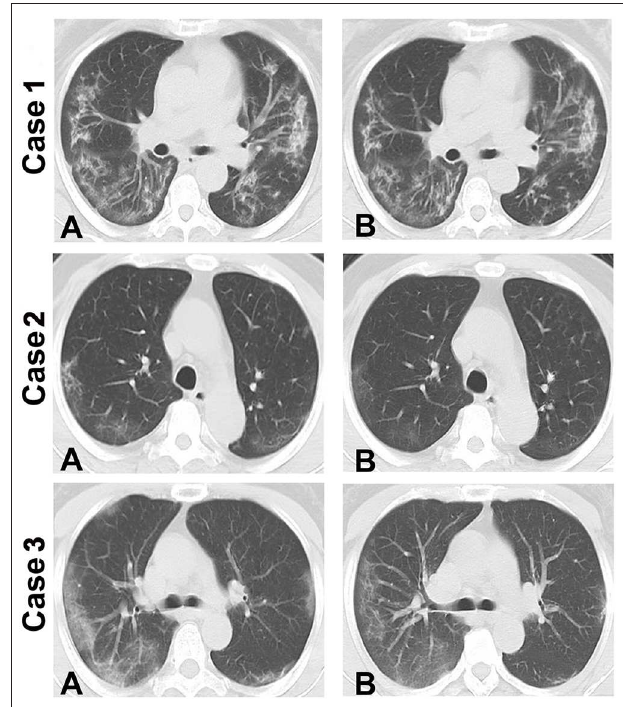
FIGURE 1 | Chest CT showing changes in 3 patients with severe COVID-19. Compared to the first transferred to ICU, chest CT showing significant absorption of exudative lesions in patient of the day before they were discharged from the ICU. (A) Chest CT images of the patients when they were first transferred to ICU. (B) Chest CT images of the patients on the day before they were discharged from the ICU showing absorption of the exudative lesions. Intensive care unit: